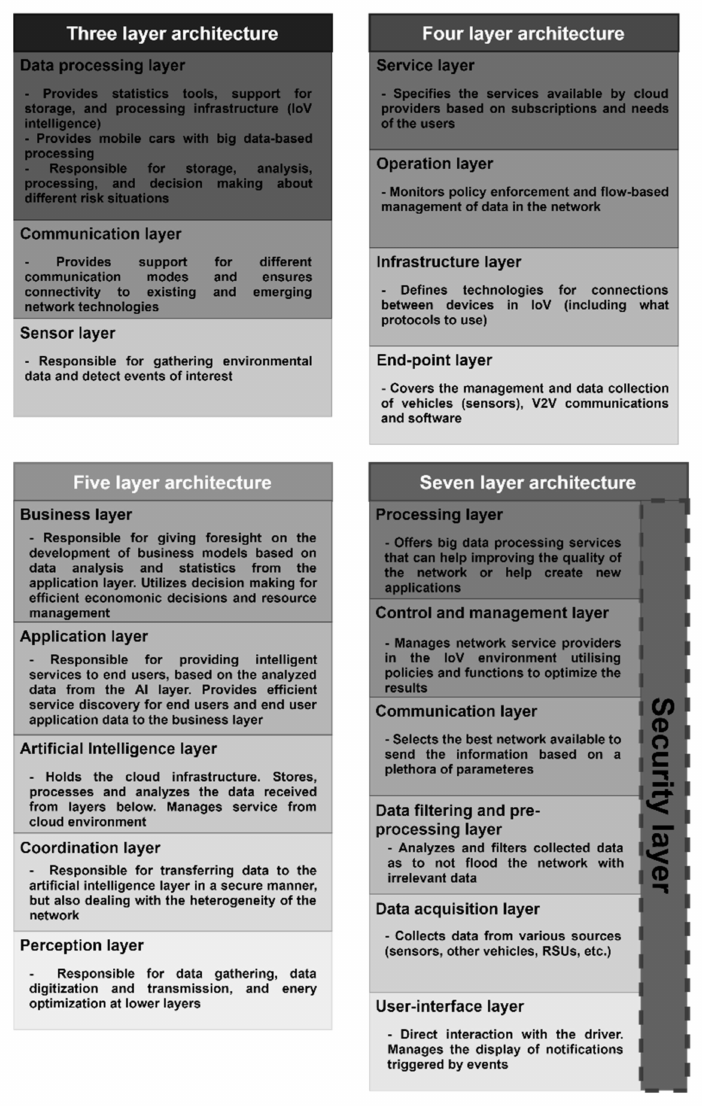
Figure 2. Comparison between the various layered architectures for